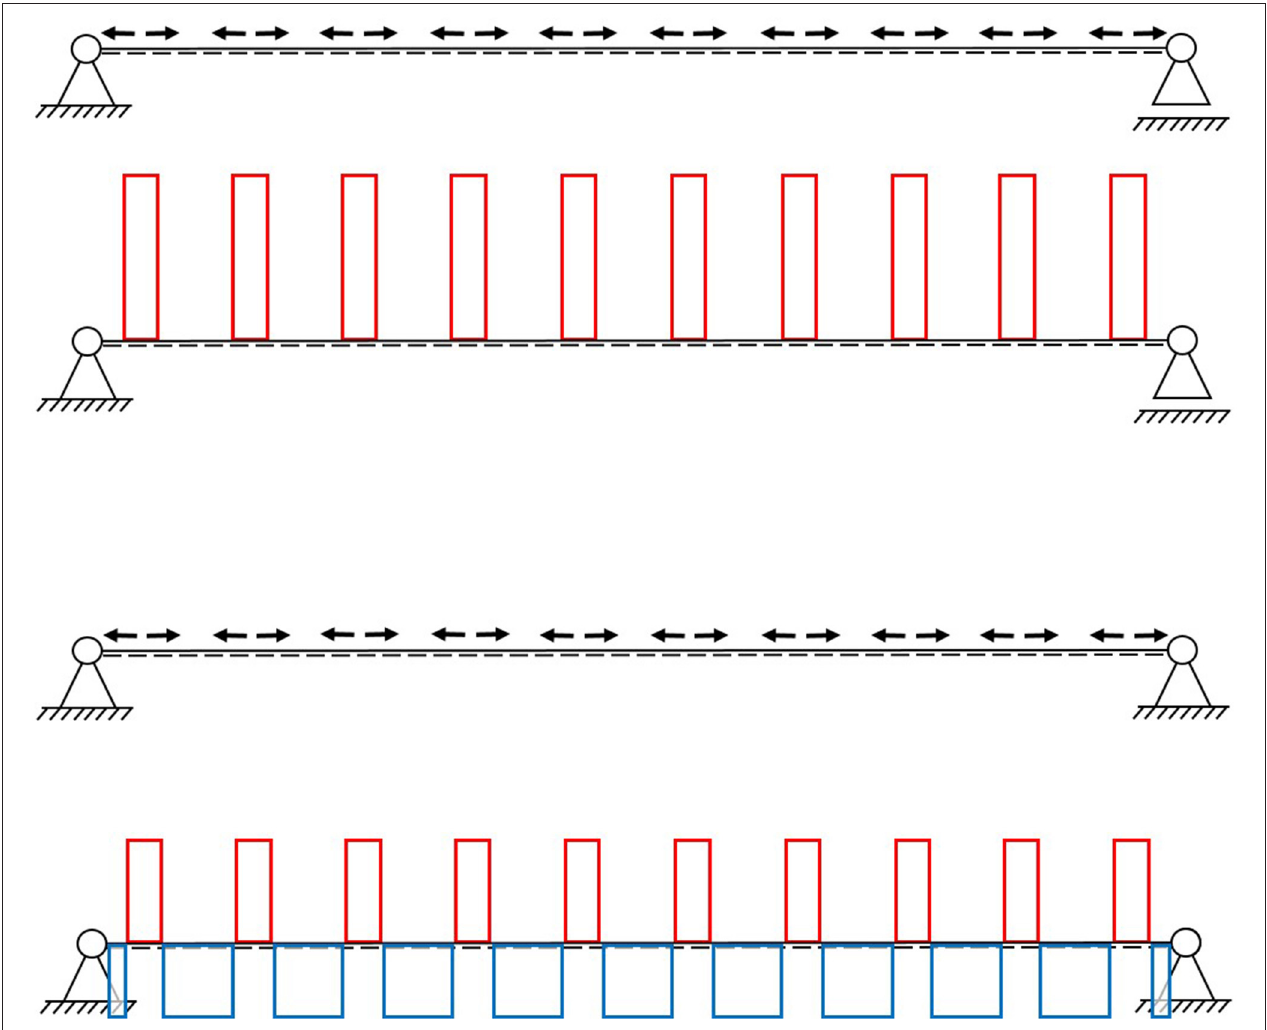
FIGURE 6 | Normal force diagram of a statically determinate (Top) and statically indeterminate (Bottom) single-span